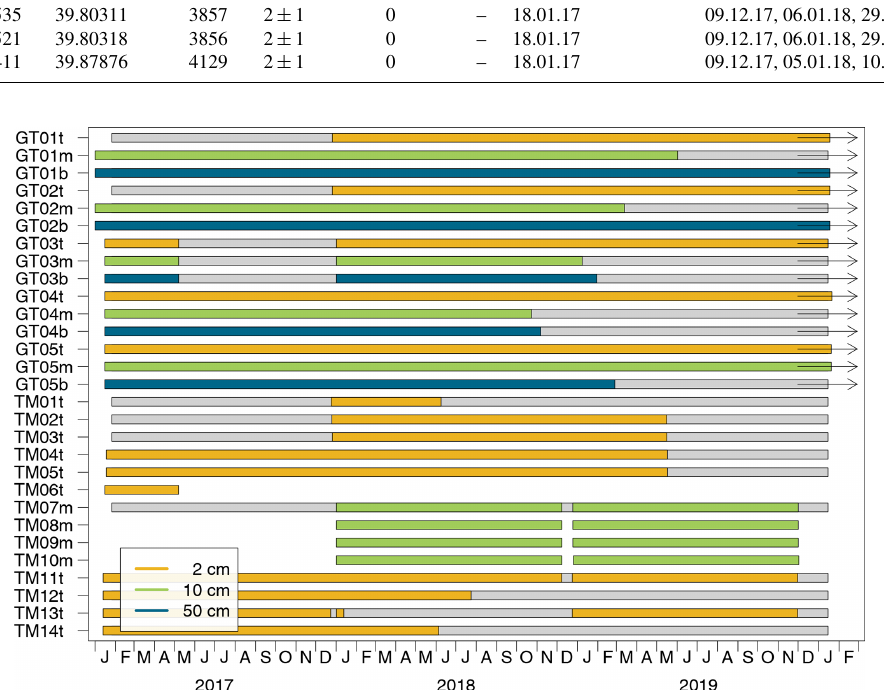
Figure 3. Measurement periods and data gaps of all ground temperature data loggers installed in the Bale Mountains. The measuring depth of a logger is colour-coded and indicated by the lower-case letters t (top, 2cm), m (middle, 10cm), and b (bottom, 50cm). Colour bars indicate measurement periods, and grey bars indicate data gaps that were filled using a linear regression model and available ground temperature data from a nearby logger (see Sect. 3.3). The arrows mark the time series that are being continued.